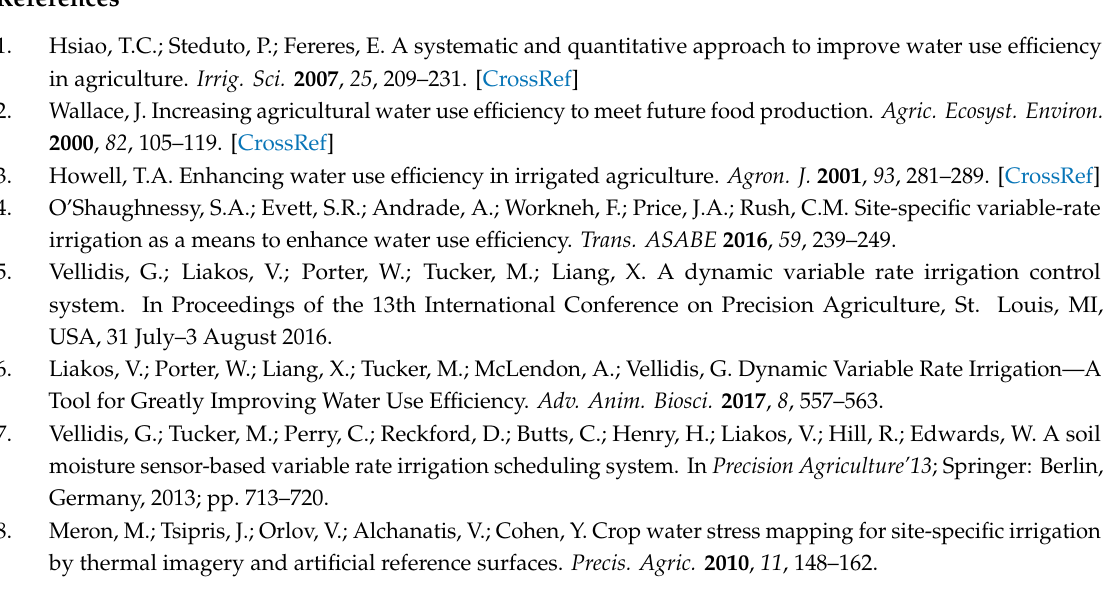
Figure S1. Comparison between measured biomass and SEBAL biomass estimates in the three irrigation management zones at 72, 102 and 115 days after planting. Figure S2. Normalized Di ff erence Vegetation Index (NDVI) maps from June 29th, 2009 and June 24th, 2013 utilized for the definition of the irrigation management zones in the experimental area. Figure S3. Normalized Di ff erence Vegetation Index (NDVI) maps from April 19th (a), May 14th (b), June 6th (c), July 8th (d), July 24th (e), August 9th (f), 2015 used from the Surface Energy Balance Algorithm for Land (SEBAL) to calculate actual evapotranspiration